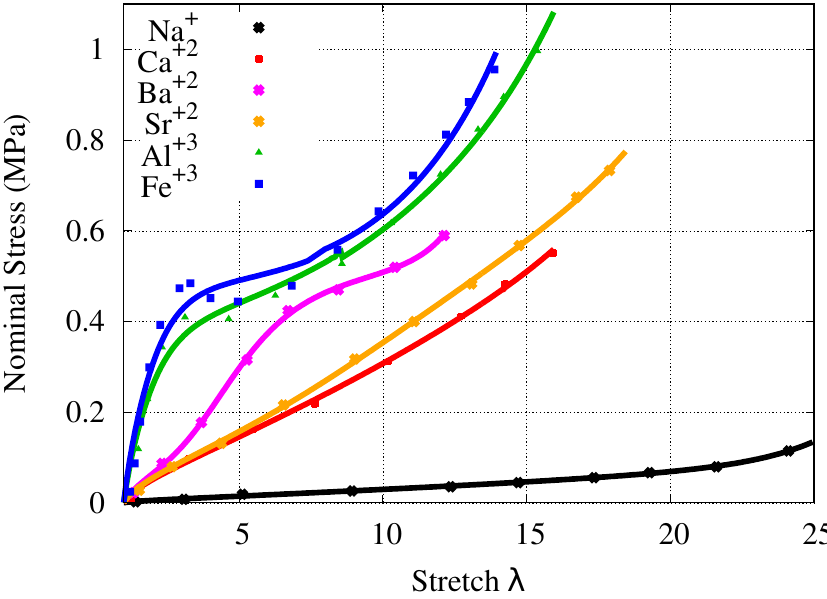
Figure 1. Comparison of the model with the stress-stretch curves of various alginate-PAAm double network hydrogels (DNHs), which are elongated to rupture [23]. (Lines: proposed model. Points: experimental